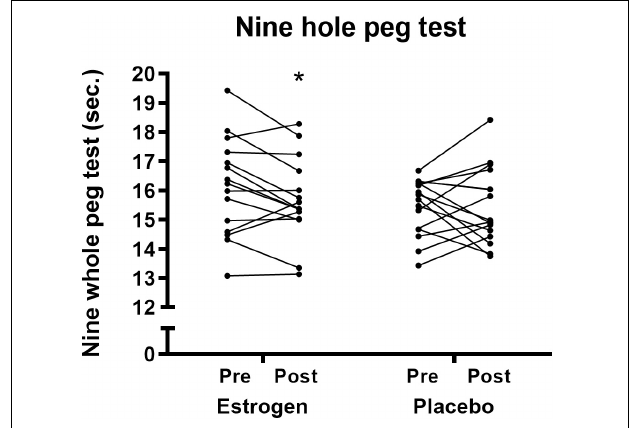
FIGURE 5 | Nine hole peg test before and after 12 weeks of resistance training in the individual participants in the ET and PLC group, respectively. A lower time indicates an improvement. *Different from pre in the individual group ( p <